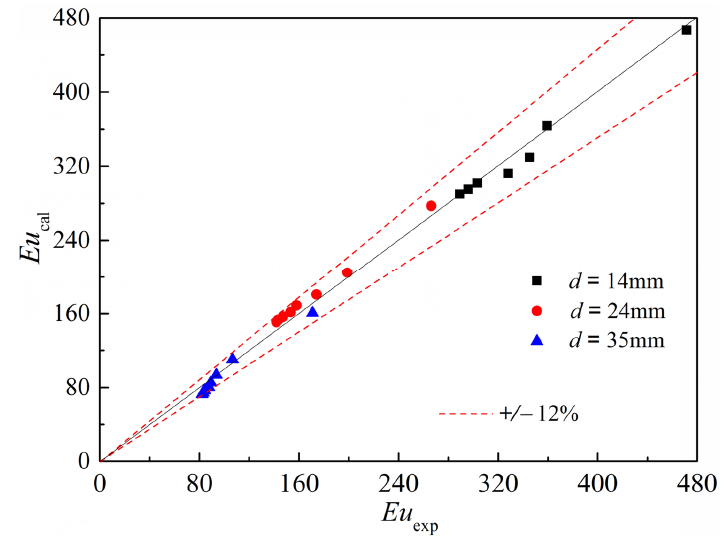
Figure 7. Comparison between experimental values and calculation values of Equation (12).